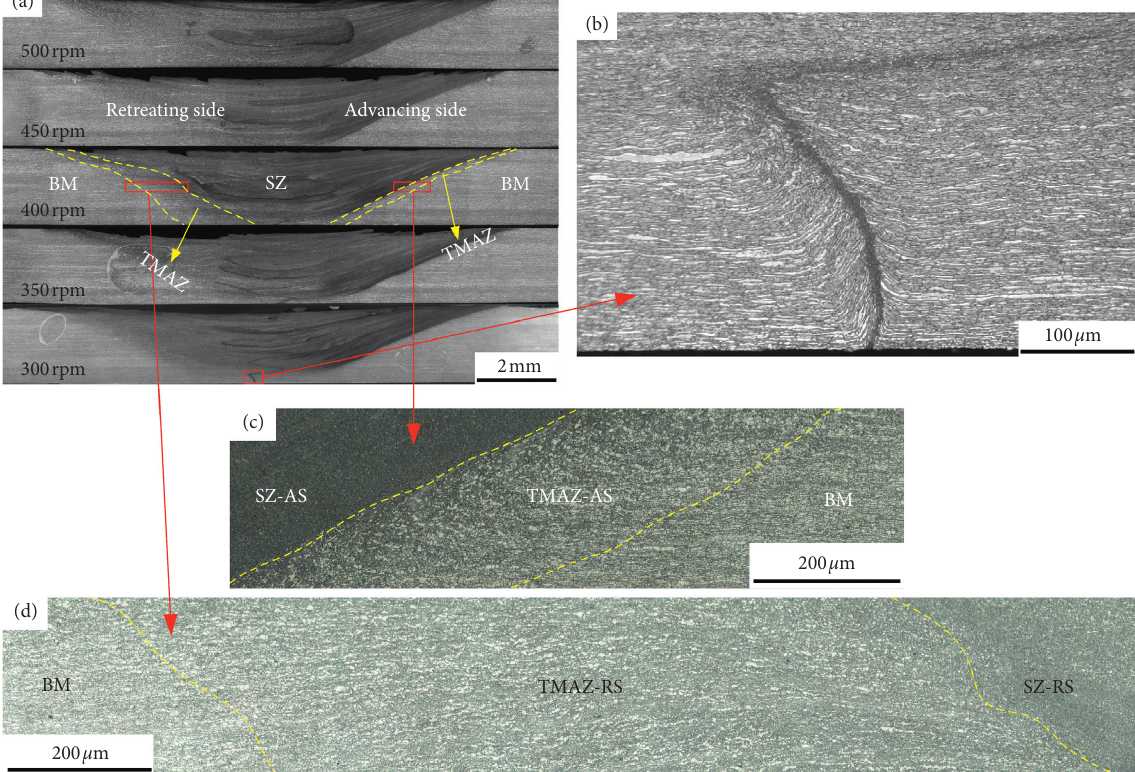
Figure 6: (a) The macrographs of the weld cross sections formed under different rotation speeds, (b) the lack of penetration defect in the joint welded at 300rpm, (c) the micrograph of TMAZ-AS of the joint welded at 400rpm, and (d) the micrograph of TMAZ-RS of the joint welded at